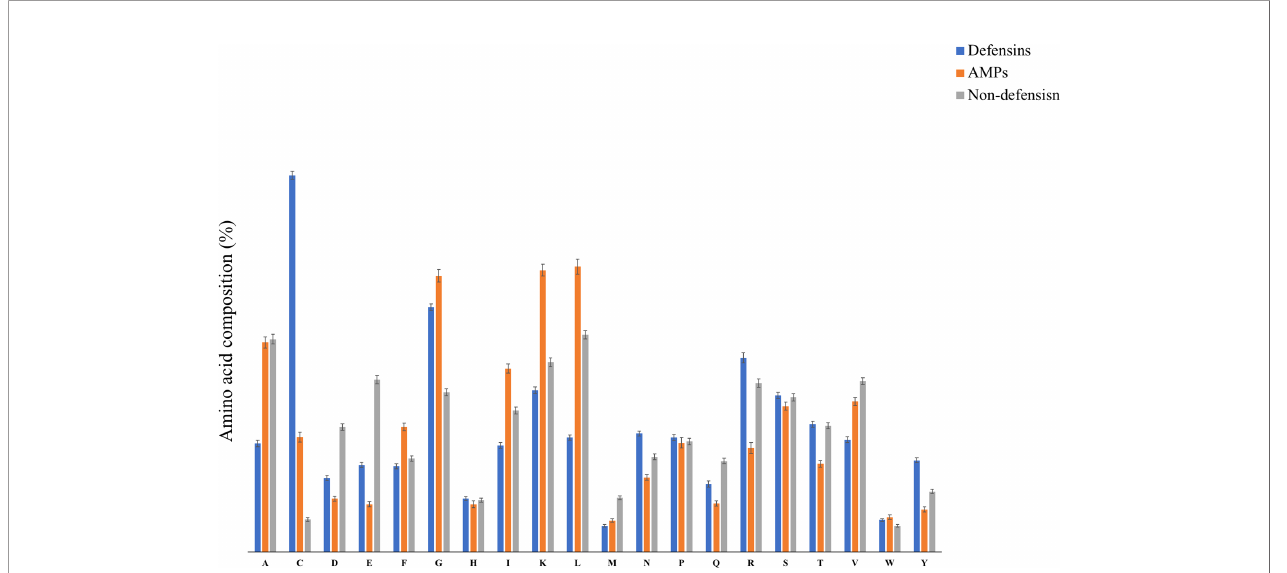
FIGURE 3 | The average amino acid compositional analysis among defensins, AMPs, and